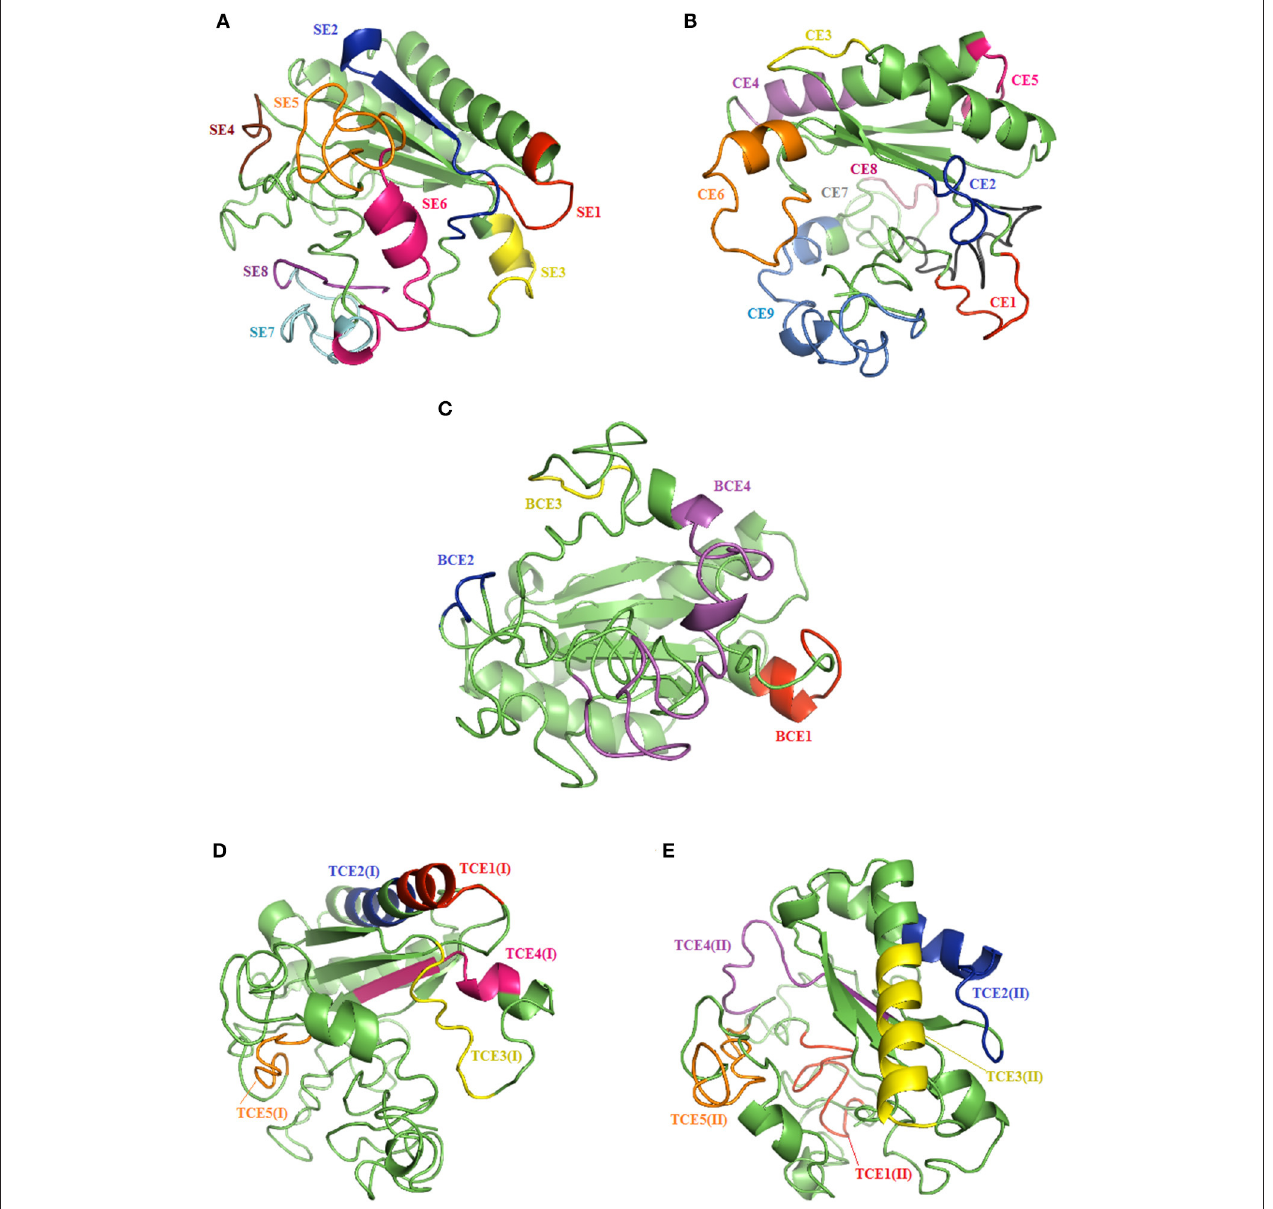
FIGURE 5 | Results of the tertiary structure prediction of the reference OmpA protein (V1) showing linear (A) , conformational (B) , and common (C) epitopes bound to B cells, and MHC class I (D) and II (E) T-cell epitopes.